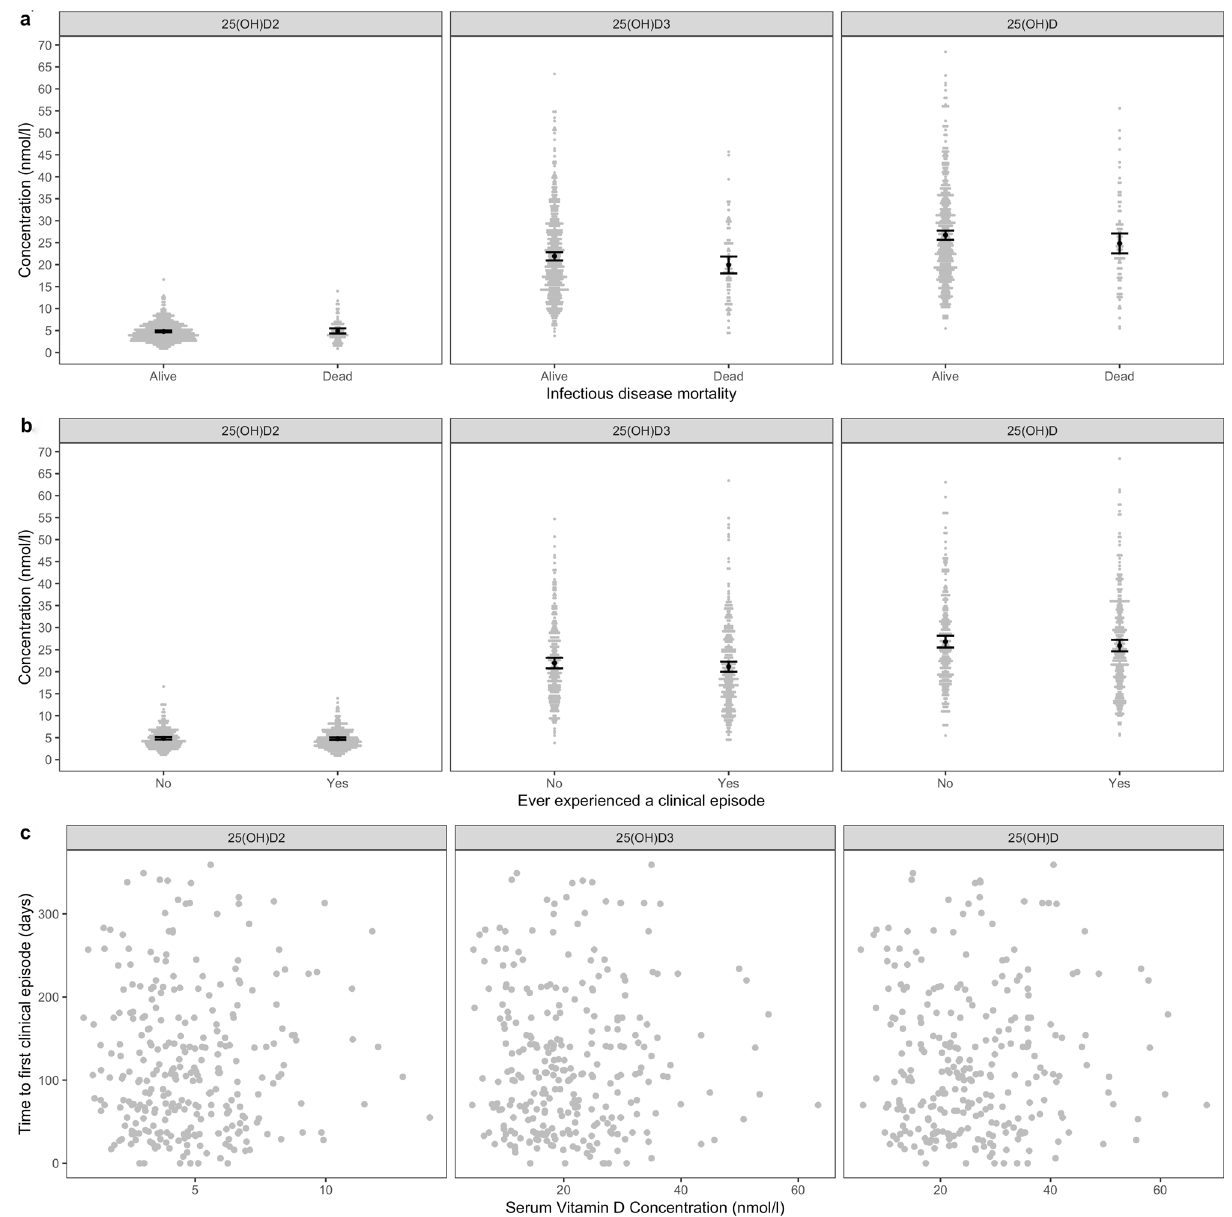
Figure 8. Serum 25(OH)D concentration and infectious disease mortality and morbidity by one year of age. Black points represent the mean with 95% confidence interval. (a) Infectious disease mortality; (b) experiencing a clinical episode by 51 weeks of age and (c) time to first clinical episode vs. serum 25(OH)D Statistical analysis. The distributions of the total 25(OH)D, 25(OH)D 2 and 25(OH)D 3 were examined and the difference in median concentrations of 25(OH)D 2 and 25(OH)D 3 within samples were tested with a paired Wilcoxon signed rank test, as well as their correlation (Spearman rank correlation). Unless otherwise stated, all analysis was carried out using R version 3.6.0 71 and the figures were created using the R package ggplot2 72 . Association with calf level factors. The calf level factors associated with serum 25(OH)D concentra- tion was investigated using multi-model inference with model averaging. Calf level factors which were initially thought to be associated with serum 25(OH)D concentration were: calf gender; dam and calf coat colour, coat pattern and hair length; calf weight at recruitment; calf rectal temperature; dam body condition score and whether or not the farmer gives nutritional supplements to their herd. Correlation between calf level variables were assessed using Pearson’s product moment correlation for the continuous variables and chi-squared tests for the categorical variables. Since calf coat colour was correlated with variables which described both the dam’s and the calf’s coats, we avoided collinearity issues amongst the explanatory variables by only including calf coat colour in the global model to represent the coat descriptions.